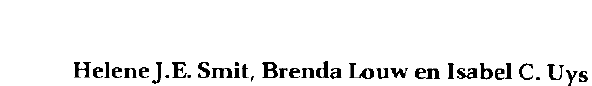
Tabel 4: Opsommende tabel van Dore (1978) se meto-